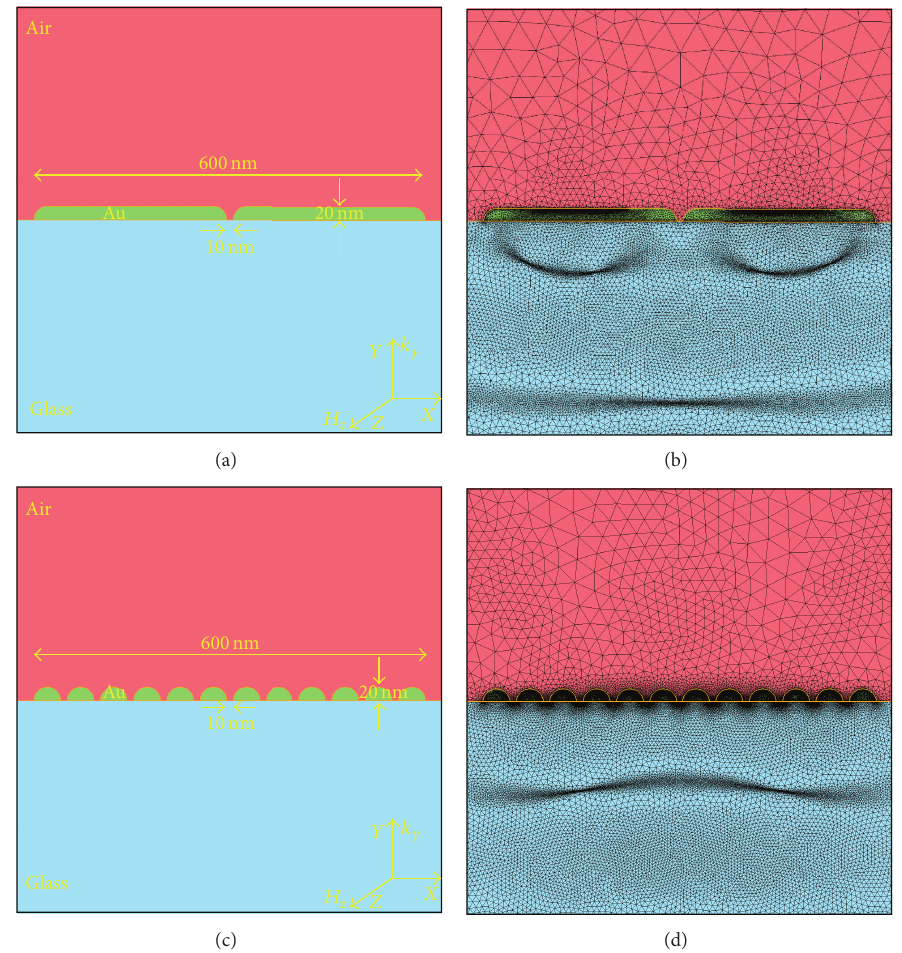
Figure 1: Geometries ((a), (c)) and the final adapted meshes ((b), (d)) for 2 and 12 gold nanostripes, respectively.